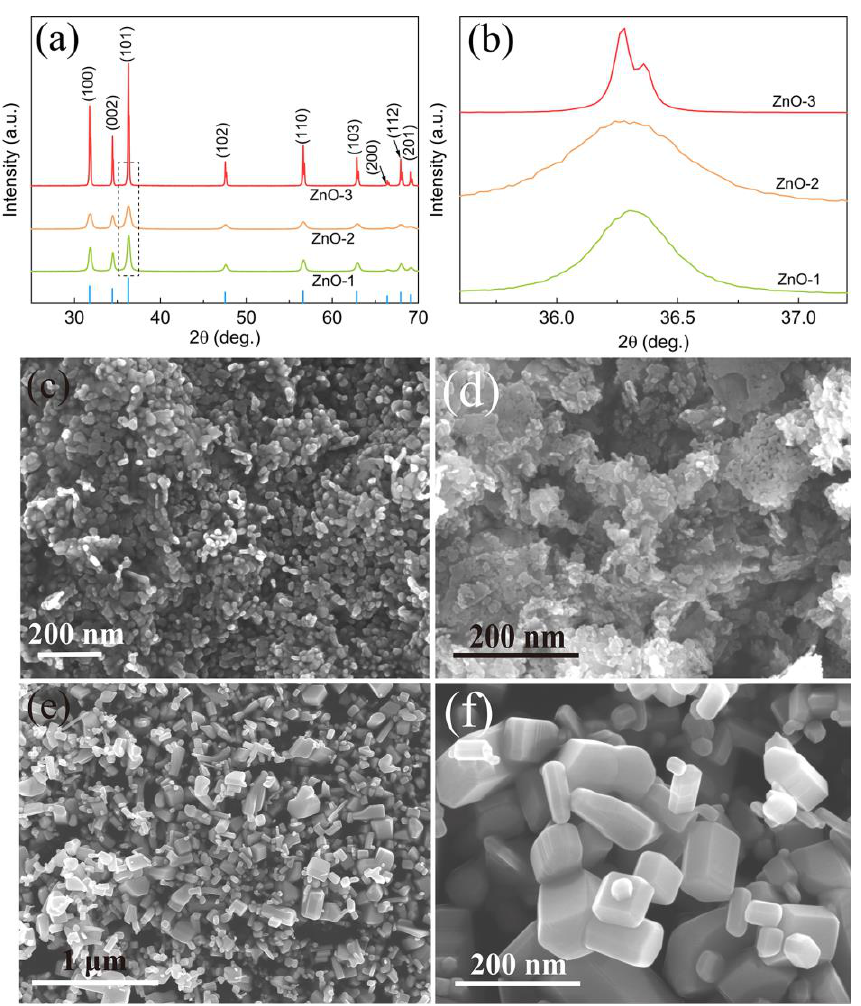
Figure 1. ( a ) XRD pattern of these ZnO powders; ( b ) normalized XRD result in the range of 35.5° – 37.3°. SEM images of three kinds of ZnO powders: ( c ) ZnO-1; ( d ) ZnO-2; ( e , f ) ZnO-3.